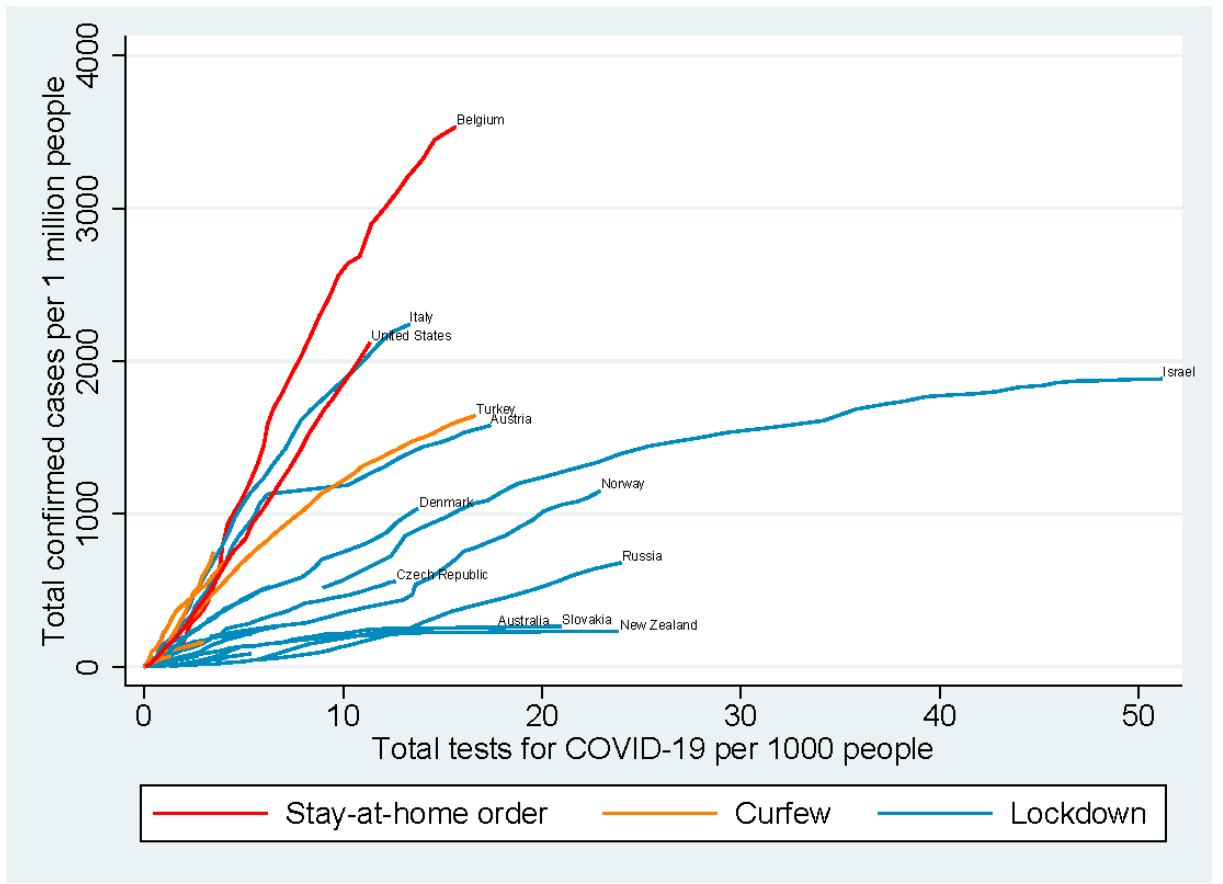
Figure 8. Total confirmed cases per 1 million people vs total tests for COVID-19 per thousand people in 54 countries by type of containment measure. COVID-19: coronavirus